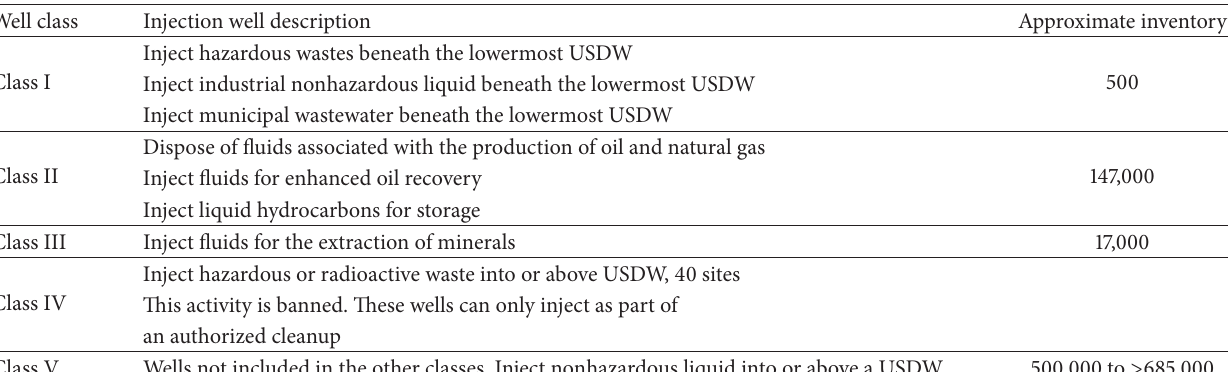
Table 4: US EPA injection well classification